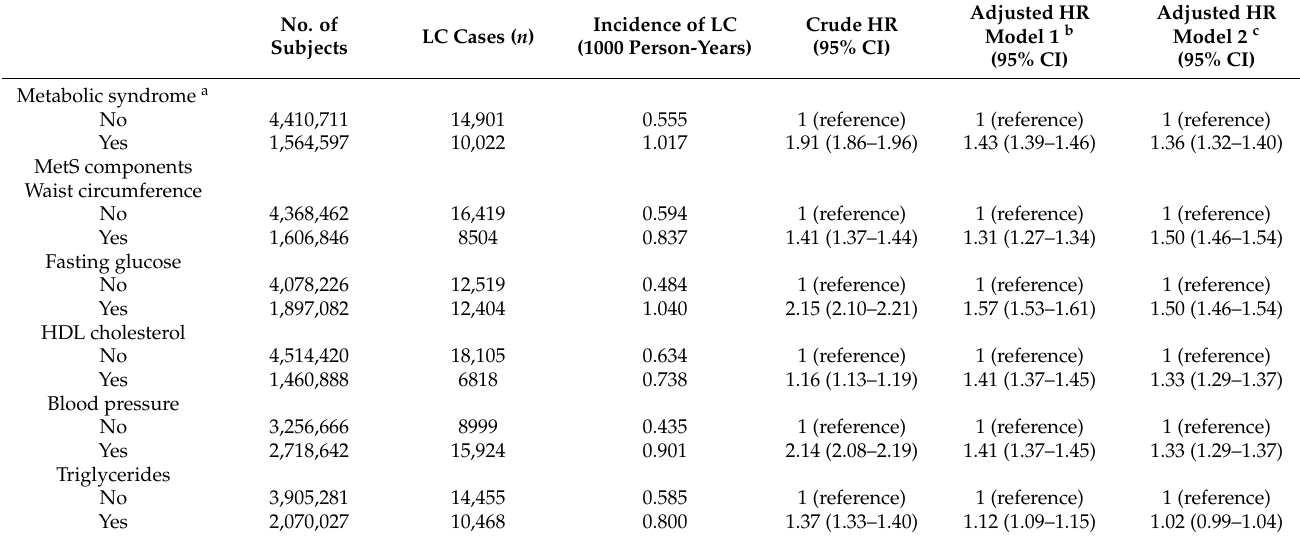
Table 2. Incidence of liver cirrhosis according to metabolic syndrome and its